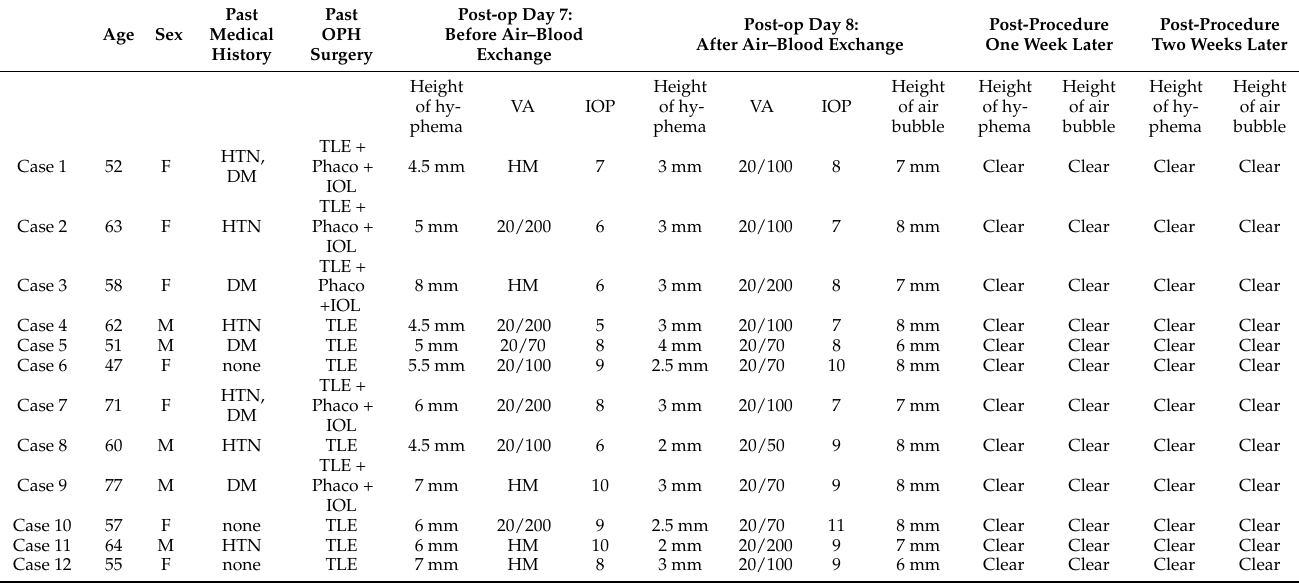
Table 1. Cases with hyphema treated by a novel air–blood exchange procedure using room air following